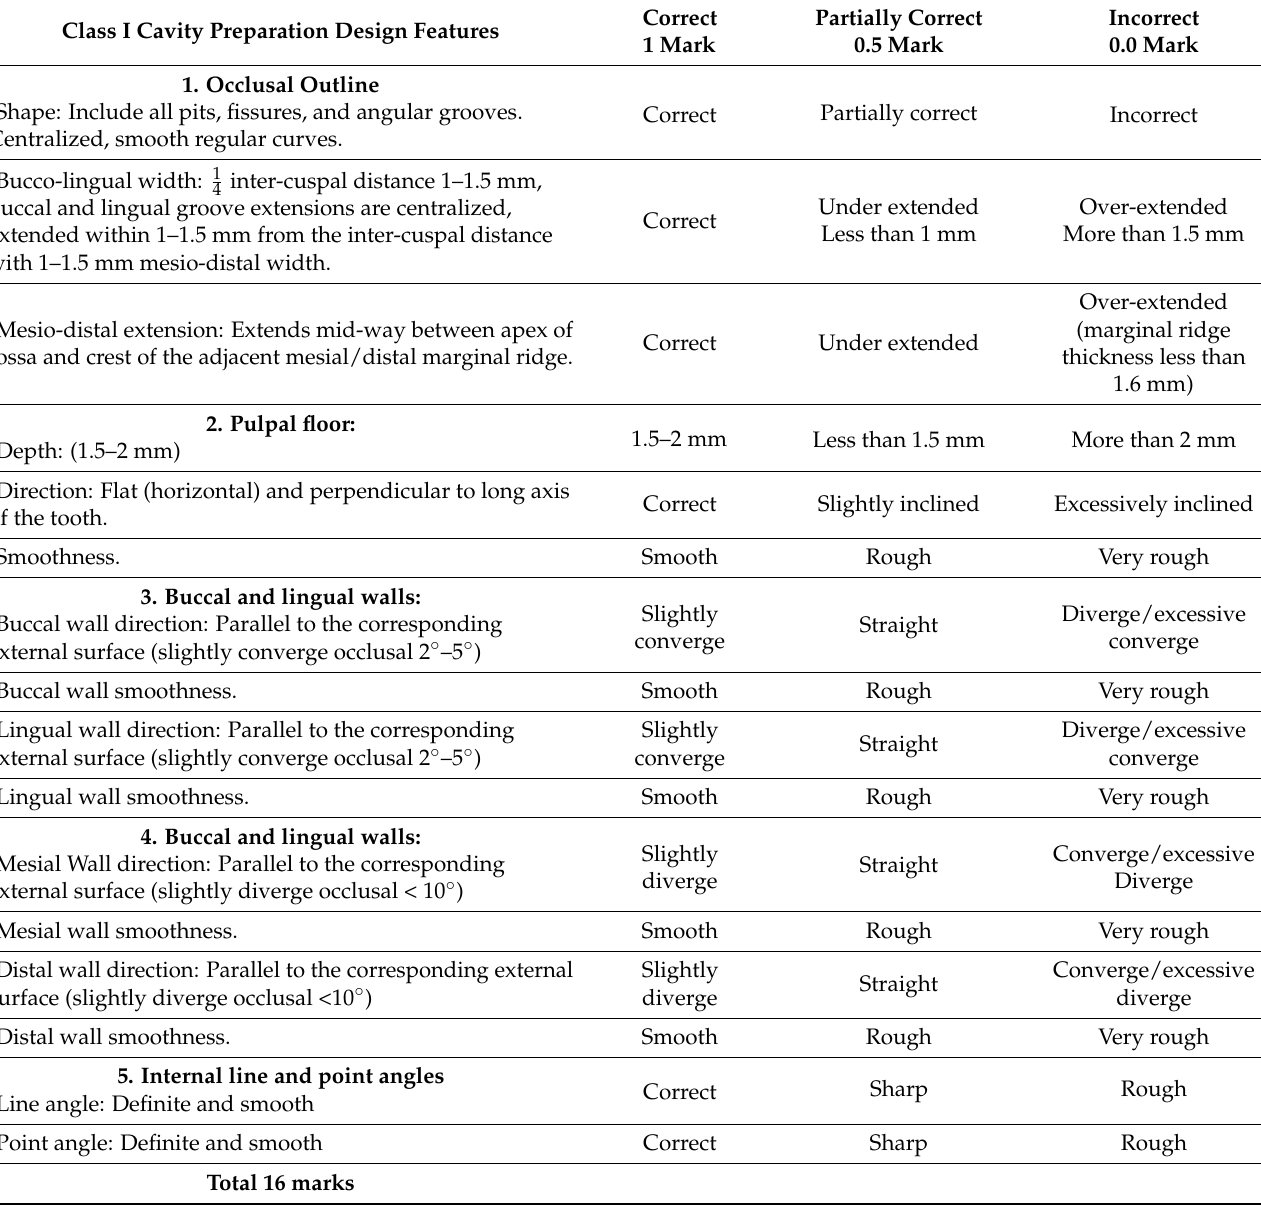
Table 1. Design features and evaluation criteria for class I cavity preparation for amalgam